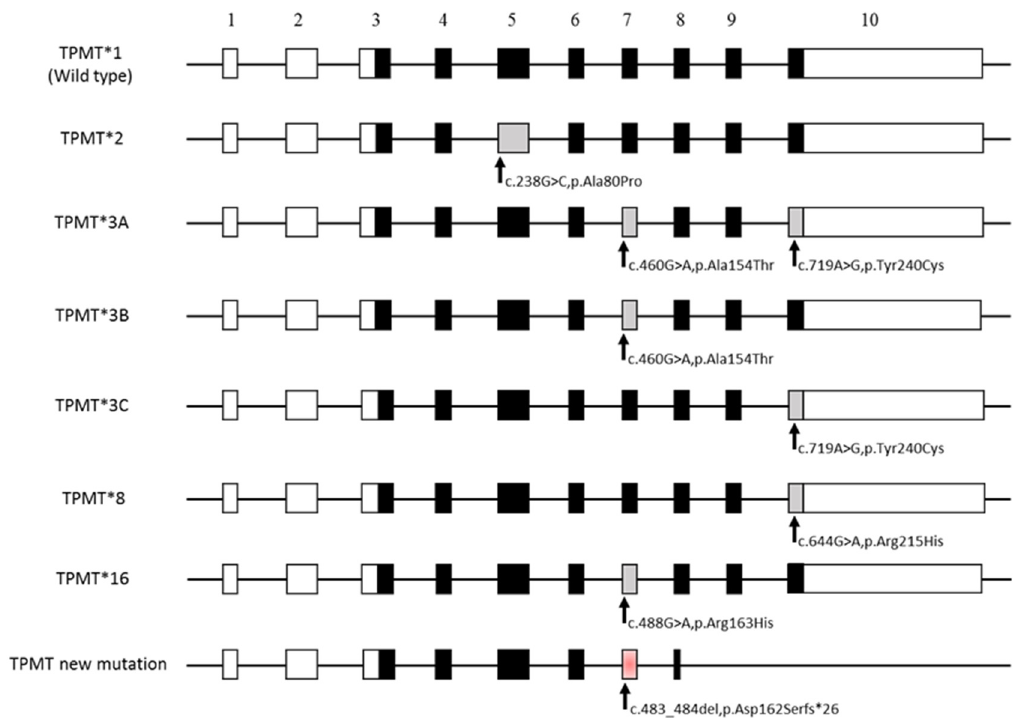
Figure 2. Allelic variants of the human TPMT locus. The TPMT gene is located on 6p22.3 (NM_000367.2, OMIM 187680) and comprises 10 exons and nine introns. Boxes depict exons in the human TPMT gene and spaces between boxes are introns. White boxes show untranslated exonic regions and black boxes represent exons in the open reading frame (ORF). Grey boxes correspond to different exons with molecular alterations inducing changes in amino acids. The positions of the most frequent SNPs are indicated by vertical arrows. The red box shows exon 7 with the c.483_484del, p.Asp162Serfs * 26 mutation inducing a TPMT * 16 mutation (c.488G > A,p.Arg163His). TPMT * 2, * 3A, and * 3C represent more than 90% of inactive alleles [57]. Among the most